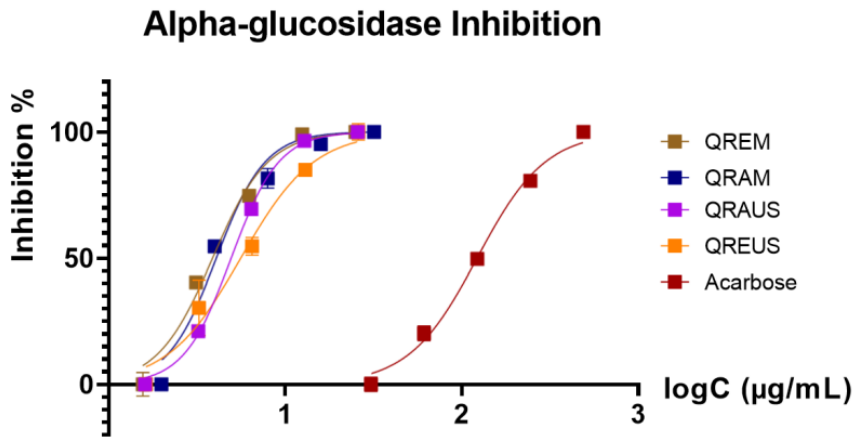
Figure 3. Graphical representation of the dependence between the logC (of the concentration ex- pressed as µ g/mL) and the inhibition percentage against the α ‑glucosidase of the Q. robur older bark extracts, using the activity of acarbose as the positive control.